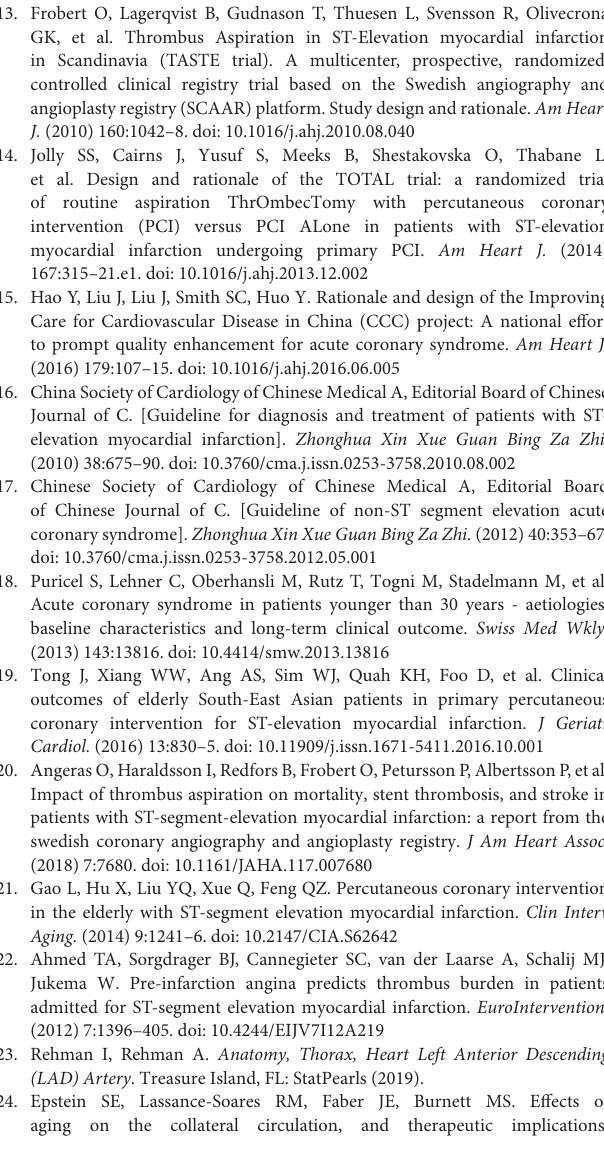
Supplementary Figure 1 | Logistic regression analysis revealed that thrombus aspiration was less likely to be conducted with the increase of age. PPCI, primary percutaneous coronary intervention; TA, thrombus aspiration; CI, confidence interval. Supplementary Figure 2 | LVEF and the rate of region wall motion abnormality before discharge. (A,B) For patients ≤ 75 years, patients undergoing thrombus aspiration treatment presented with lower LVEF and a higher rate of regional wall motion abnormality. While for patients > 75 years, no significant difference was observed between the two treatment groups. RWMA, regional wall motion abnormality. Supplementary Table 1 | The baseline characteristics of the matched patients ( n =